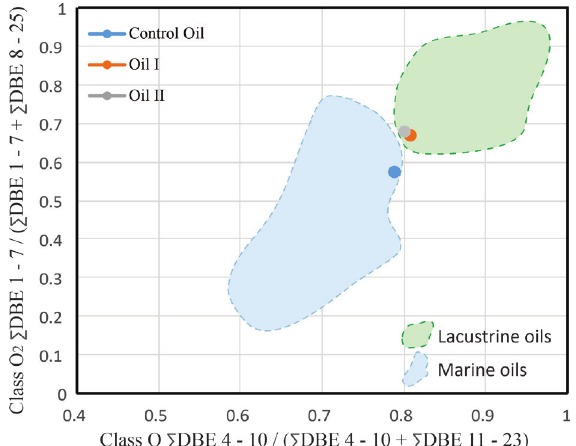
Figure 9. Depositional environment assessment of oil samples (I, II, and Control Oil) based on the distribution of O polar compounds investigated by 1 negative ESI FT-ICR